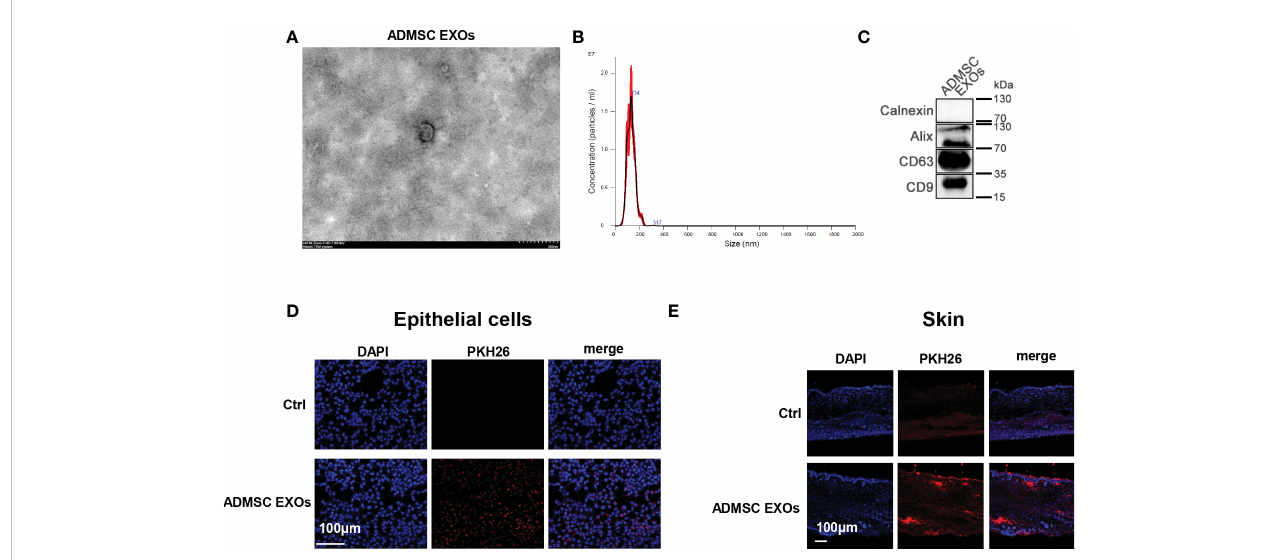
FIGURE 1 ADMSC derived exosomes directly taken up by skin. (A, B) Transmission electron microscopy (A) and nanoparticle size tracking (B) assay of exosomes extracted from ADMSC cell culture medium. (C) Analysis of the protein markers (CD9, CD63, and Alix) in ADMSC exosomes through western blot. (D, E) PKH26 stained ADMSC exosomes could be taken up by epithelial cells (D) and mouse skin tissues (E)